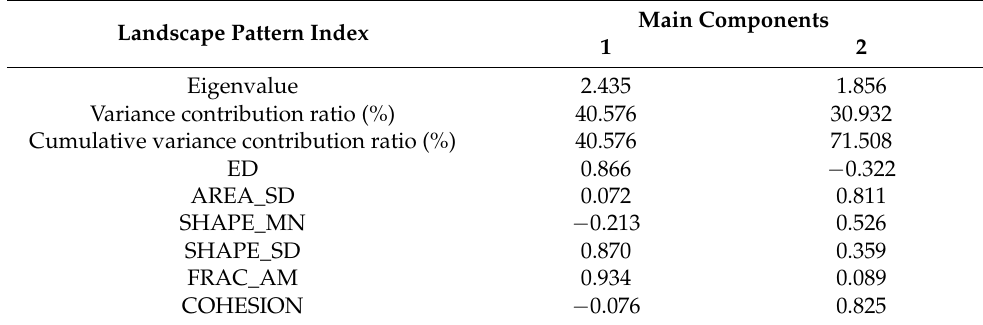
Table 4. Results of the Landscape Pattern Index Factor Analysis.